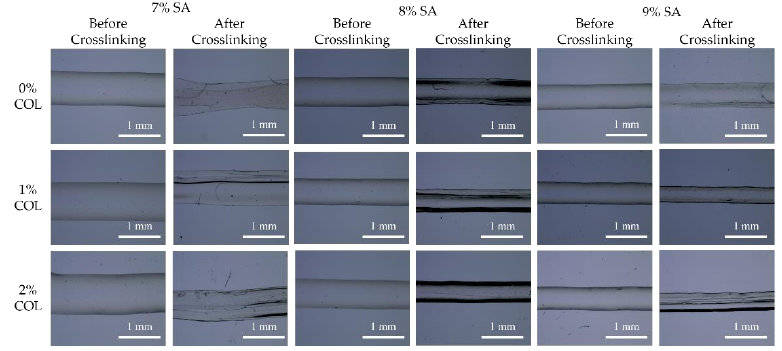
Figure 6. Images of filament before and after crosslink. After filament measurements, Minitab was used to analyze the statistical significance. Table 1 listed the average filament diameter and shrinkage ratio after crosslinking and